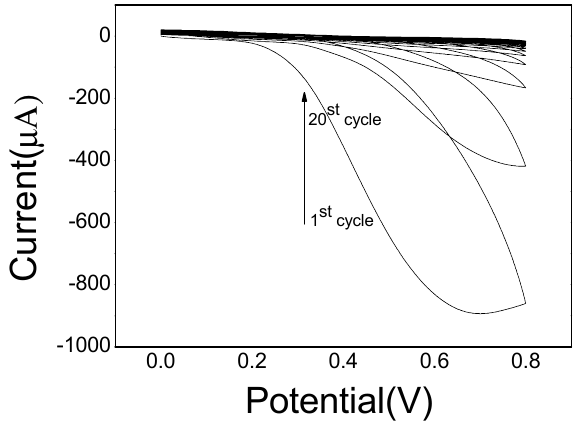
Figure 3. CV curve of electropolymerization of oPD on ERGO/GCE.